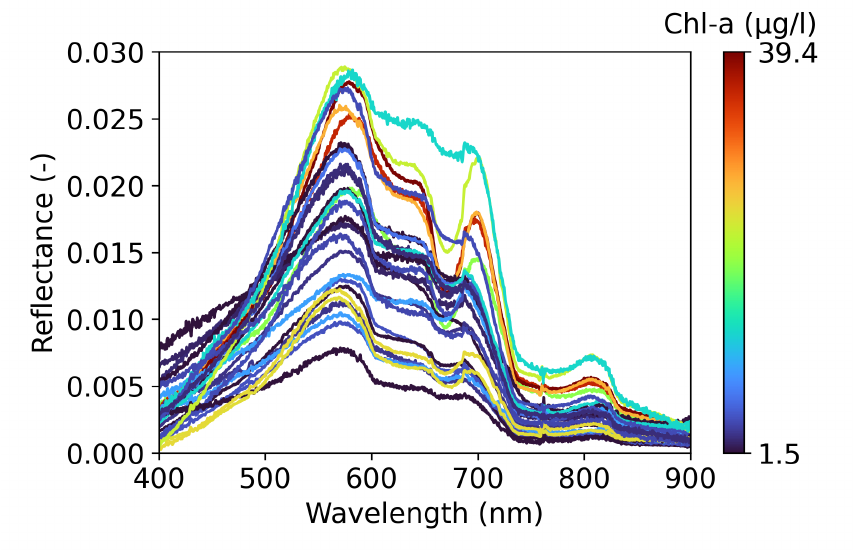
Figure 4. Water reflectance spectra taken with the HYPSTAR and coincident Chl a concentrations from the water sampling